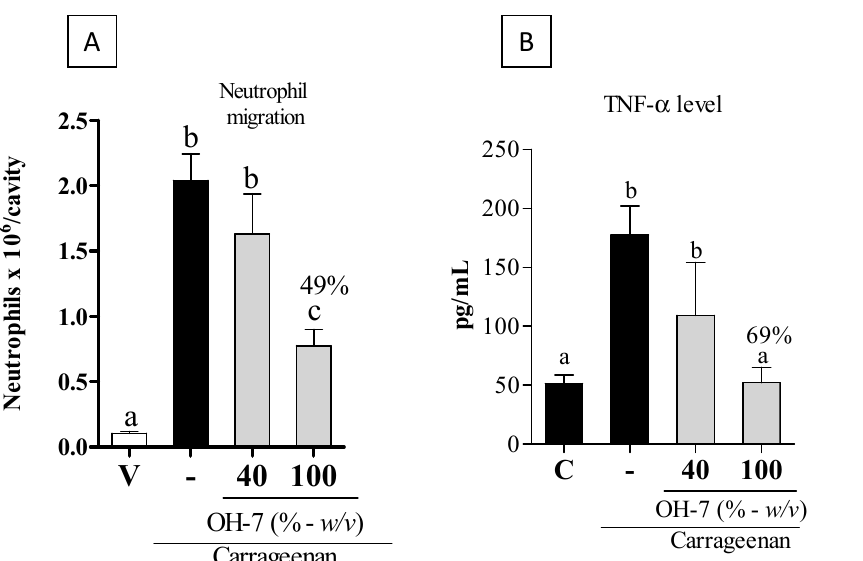
Figure 4. Effects of OH-7 on neutrophil migration and TNF- α release in vivo. ( A ) Effect of vehicle— V (NaCl solution 0.9%), carrageenan (-), and OH-7 (40% and 100%) on neutrophil migration into the peritoneal cavity of mice induced by i.p. administration of carrageenan (500 µ g/cavity-). ( B ) Effect of the OH-7 treatment on the release of TNF- α in mice. The results were expressed as mean ± SD, n = 5–6. Different letters indicate statistically significant intragroup differences ( p < 0.05; One-way ANOVA, followed by Tukey’s post-test).